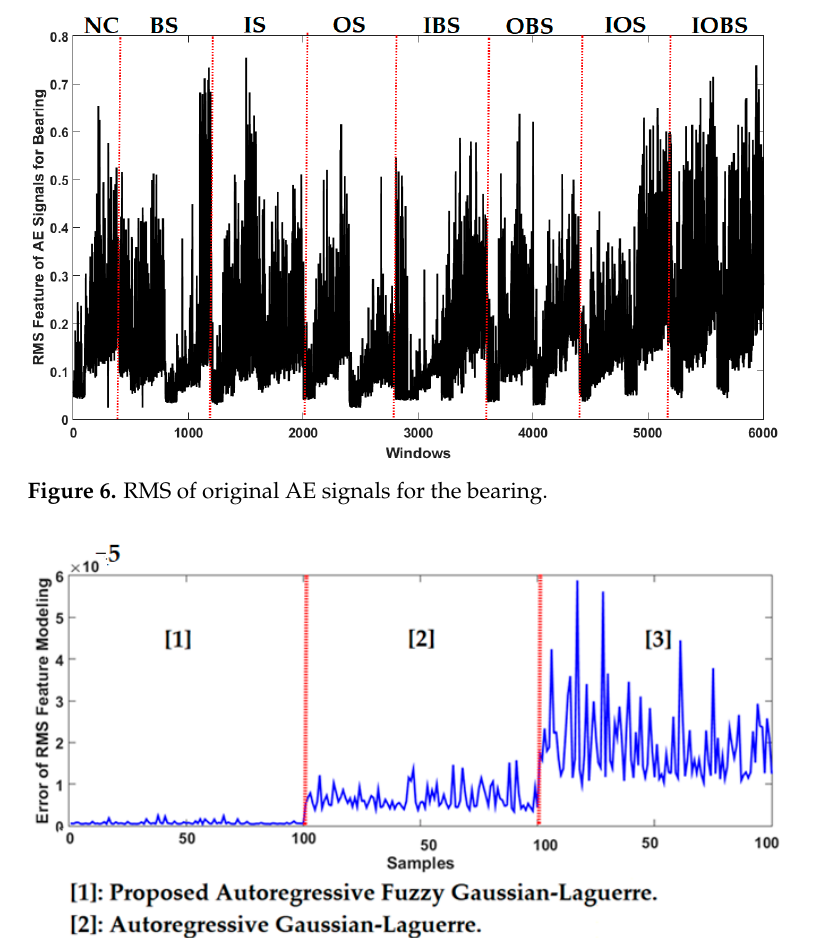
Figure 7. The error of RMS signal modeling using the proposed autoregressive fuzzy Gauss–La- guerre algorithm, autoregressive Gauss–Laguerre technique, and autoregressive Gaussian method for normal conditions. The other challenges of signal modeling are related to stability and robustness. To test the stability and robustness of the proposed autoregressive fuzzy Gauss–Laguerre algorithm, autoregressive Gauss–Laguerre technique, and autoregressive Gaussian method, the signal modeling errors are checked in normal conditions when the motor speeds are 300 RPM, 400 RPM, 450 RPM, and 500 RPM. Figure 8 illustrates the stability